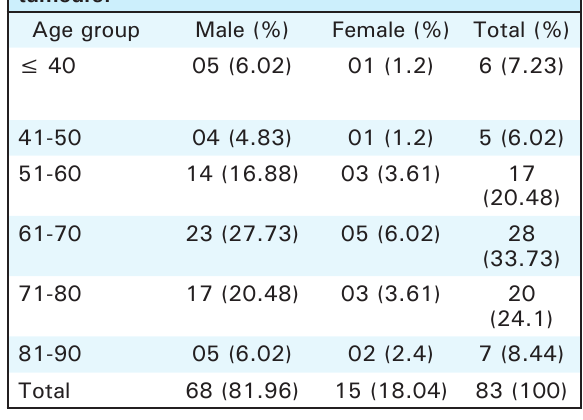
Table 3. Age and sex distribution of bladder